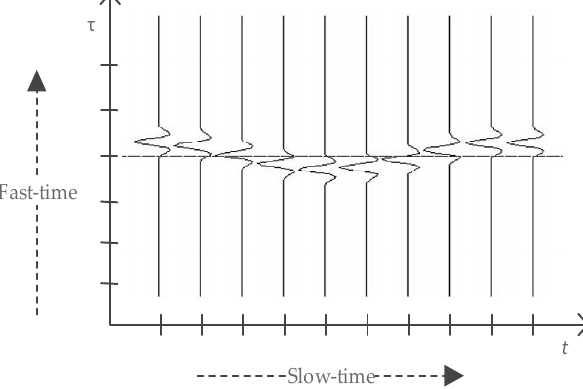
Figure 1. Schematic map of received signal with one respiratory motion and no static targets. t and τ represent the slow-time and fast-time, respectively.